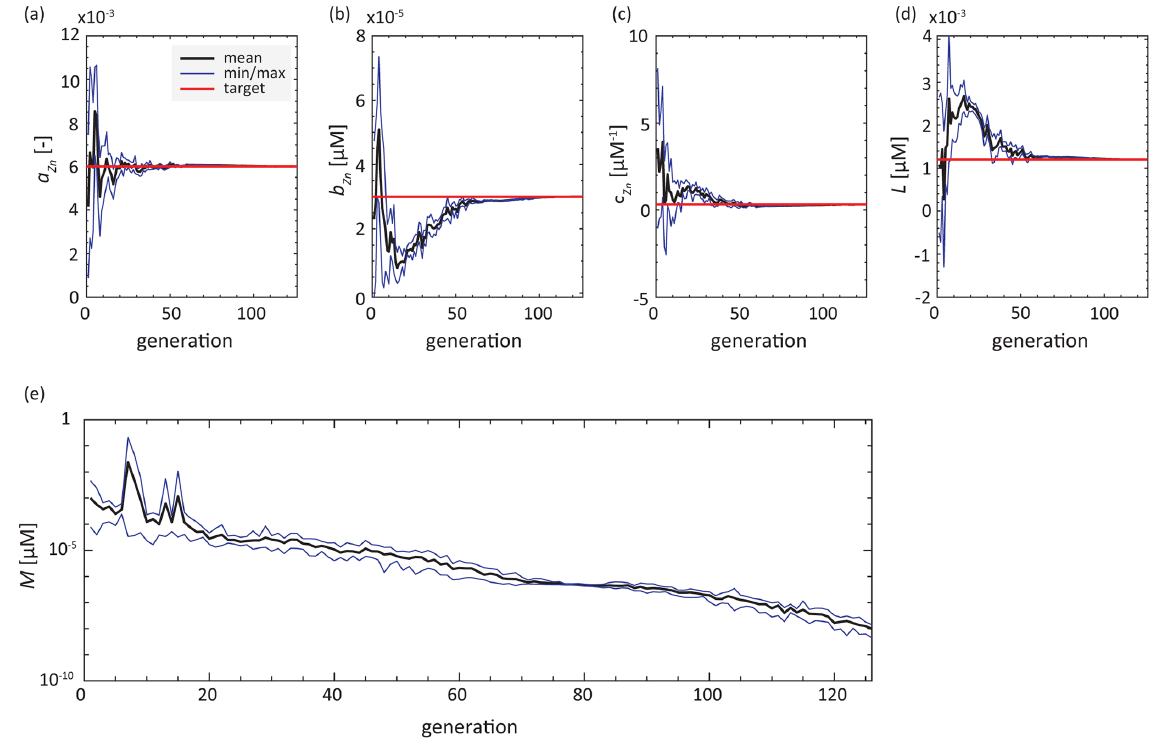
Figure 3. Evolution of parameter values and misfit (RMSE) in experiment TWIN_ALL. Red lines indicate the target parameter values. Black trajectories show the mean parameter value over all individuals in each generation of 10 individuals, while blue lines mark maximum and minimum parameter values in the generation.